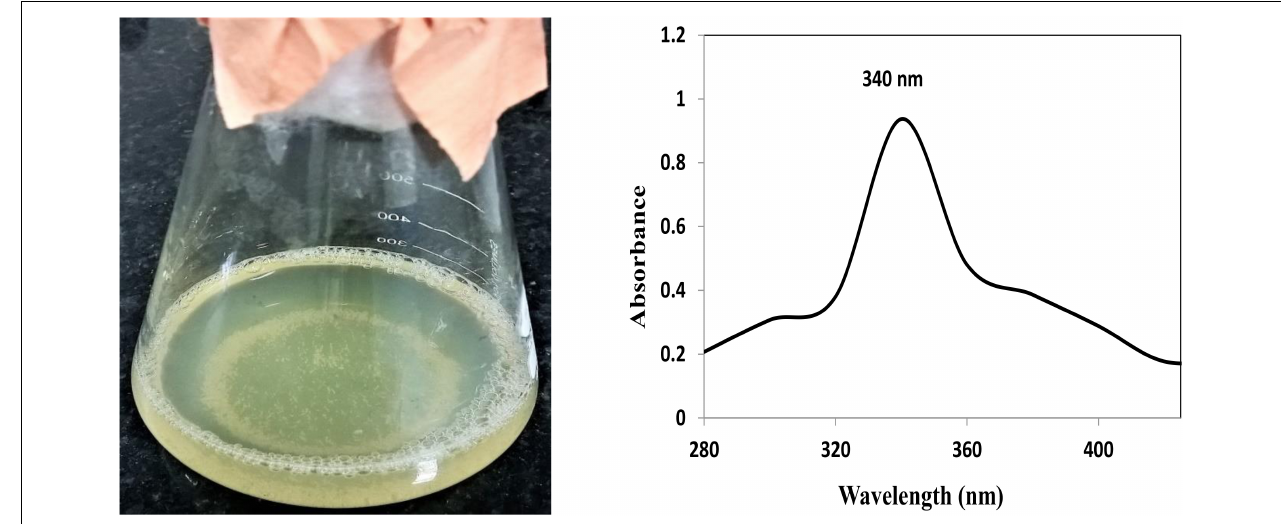
FIGURE 1 | Typical precipitate formation and UV–Vis spectra of the synthesized zinc